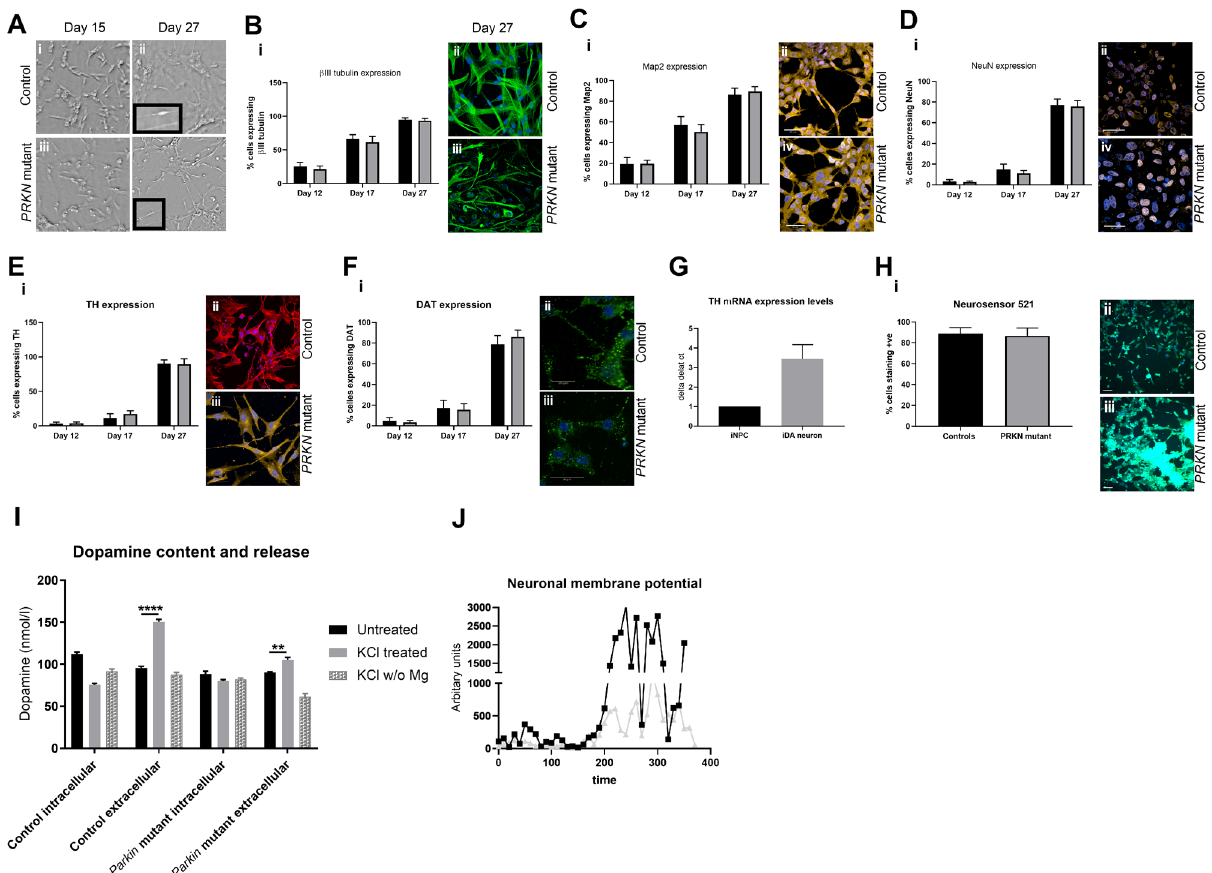
Figure 1. Control and PRKN mutant iNPC derived dopaminergic iNeuron characterization throughout differentiation. ( A ) Bright field images (scale bar = 100 µm) at day 15 and day 27. The insets show magnified regions highlighting the processes of the neurons. ( B – F ) (i) Quantification of each neuronal marker throughout differentiation in controls (black bars) and PRKN mutants (grey bars) and (ii) shows representative images of a control and PRKN mutant at day 27. ( Bii ) Green is βIII tubulin and blue nucleus. ( Cii ) Red is MAP2 and blue the nucleus. ( Dii ) Red is NeuN and blue nucleus. ( Eii ) red is tyrsosine hydroxylase and blue the nucleus. ( Fii ) green is DAT and blue the nucleus. ( G ) The quantification of mRNA expression levels for tyrosine hydroxylase in iNPC’s and day 27 neurons, showing a four fold increase in expression (black bars controls and grey bars PRKN mutants). ( Hi ) The quantification at day 27 of Neurosensor staining which stains dopamine and noradrenaline showing 90% of cells staining positive in both controls (black bars) and PRKN mutants (grey bars). (ii) shows representative images of control and PRKN mutant at day 27. ( I ) The dopamine content and release assay in control and PRKN patient neurons. Intracellular and extracellular dopamine content assessed in neurons from three rounds of differentiation for each condition. Neurons are either untreated, stimulated with potassium chloride or potassium chloride without magnesium in the buffer. Extracellular dopamine levels increase when neurons are stimulated with potassium chloride in both control (****p < 0.001) and PRKN mutant patient neurons (**p = 0.0032). J shows neuronal membrane potential in control (black line) and PRKN mutants (grey line) recorded at baseline and after stimulation at time 200 s. All quantification was done on at least three different differentiations of four control and four PRKN mutant neurons; two way ANOVA with Tukey multiple comparisons correction was